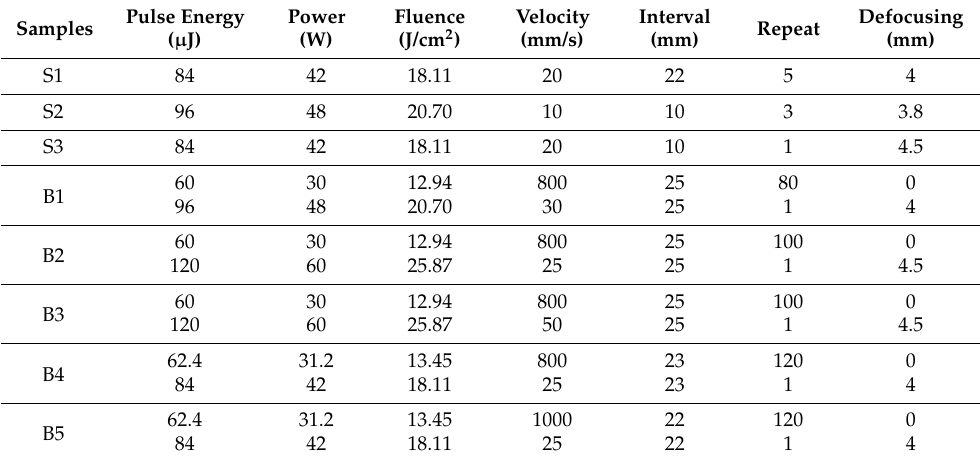
Figure 1. Schematic illustrations of two-step superimposing strategy: ( a ) polished surface, ( b ) single scan with large power, ( c ) S series structures, ( d ) repeat scan with small power, ( e ) micron-level substrate structures, ( f ) single scan with large power, and ( g ) B series structures. Table 2. Processing parameters for different samples.